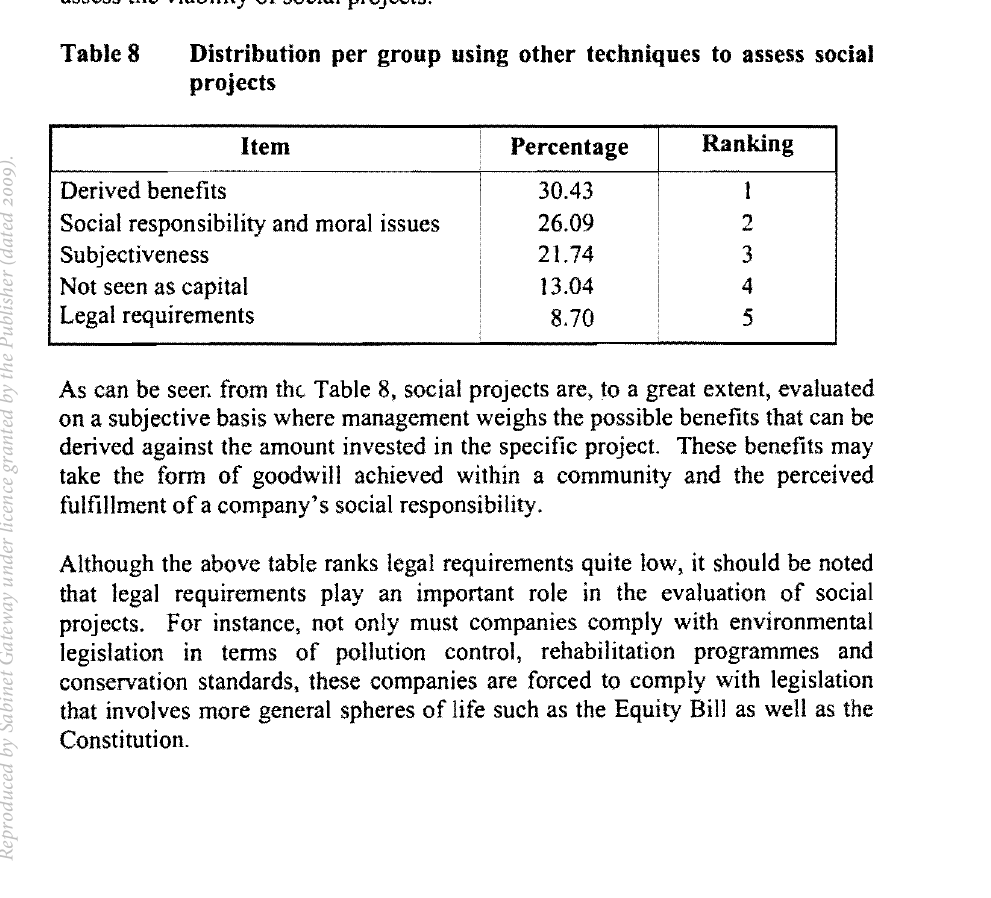
Distribution per group using other techniques to assess social projects Item Percentage Ranking Derived